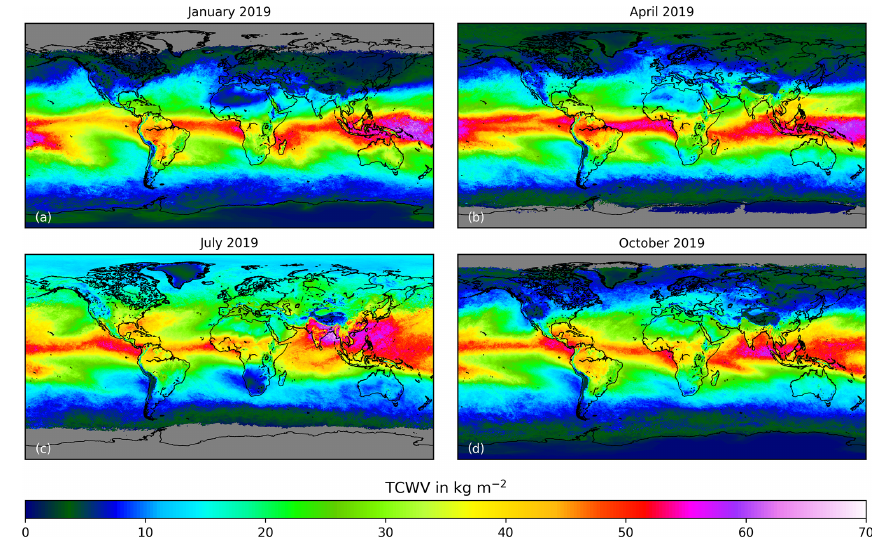
Figure 5. Global maps of mean TCWV AMC , S5P for 4 months in